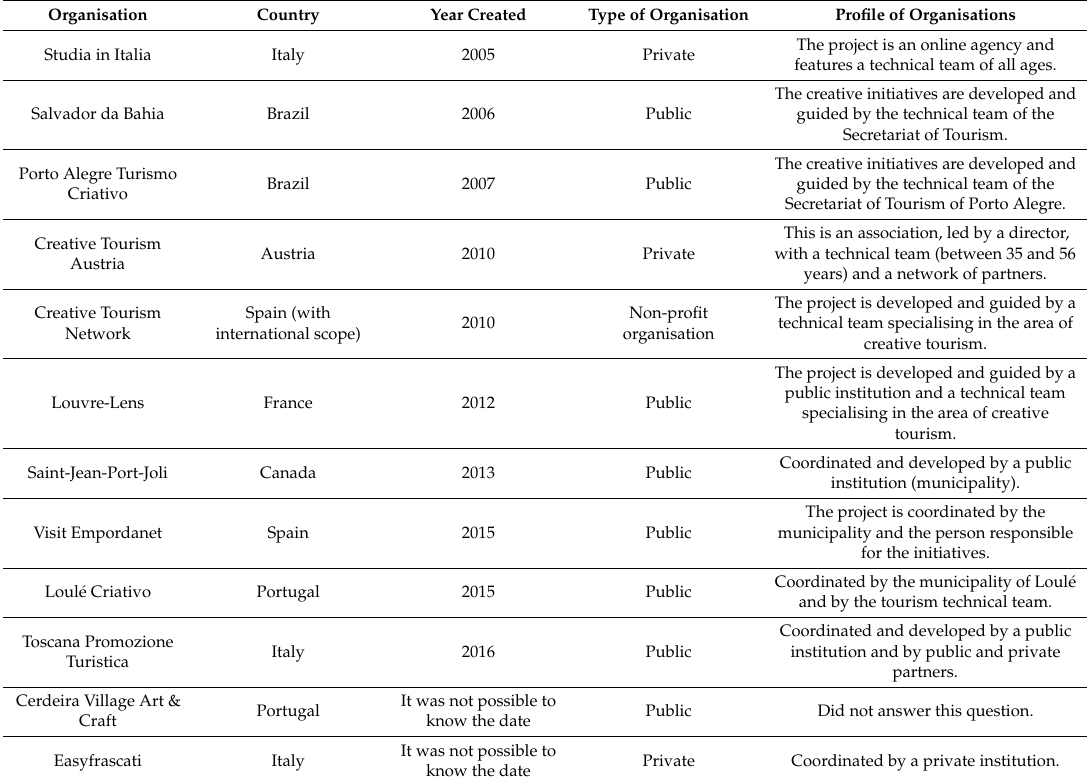
Table 2. Organisational